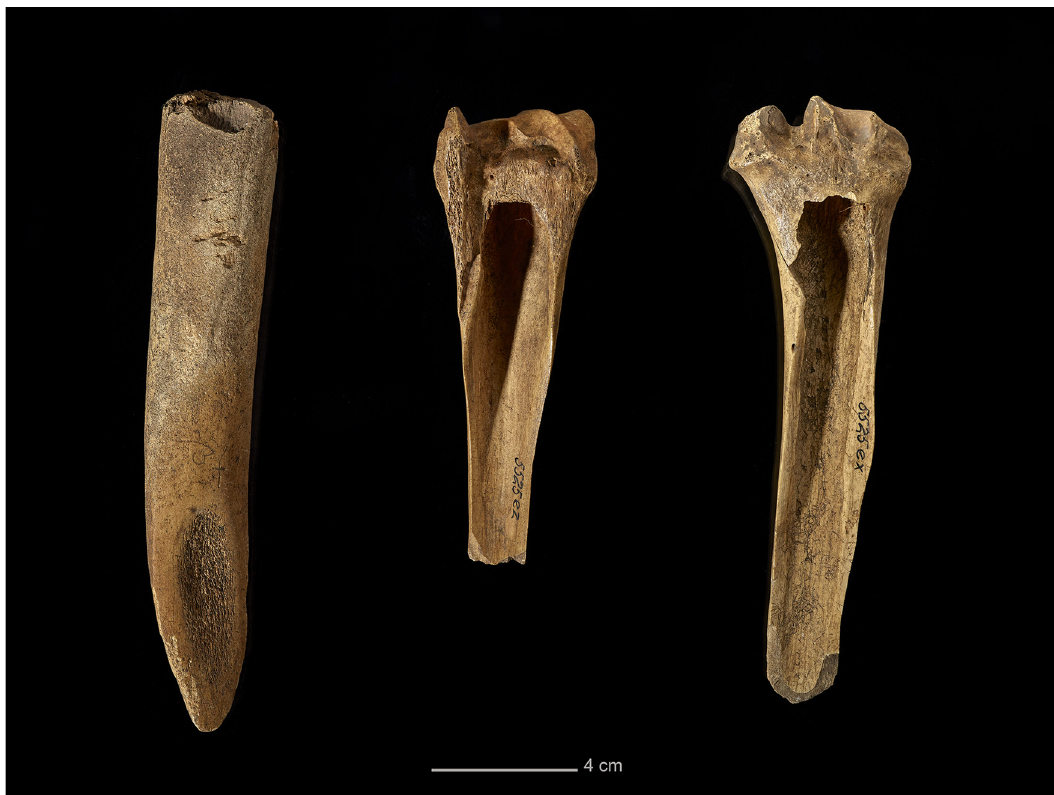
Figure 5: A bone - end - scraper from Rissebávti/Gressbakken Nedre Vest house 4 and two side - scrapers from house 3, all with heavy wear - marks and made of reindeer long - bone. Photo by M. Karlstad, UiT – The Arctic University of